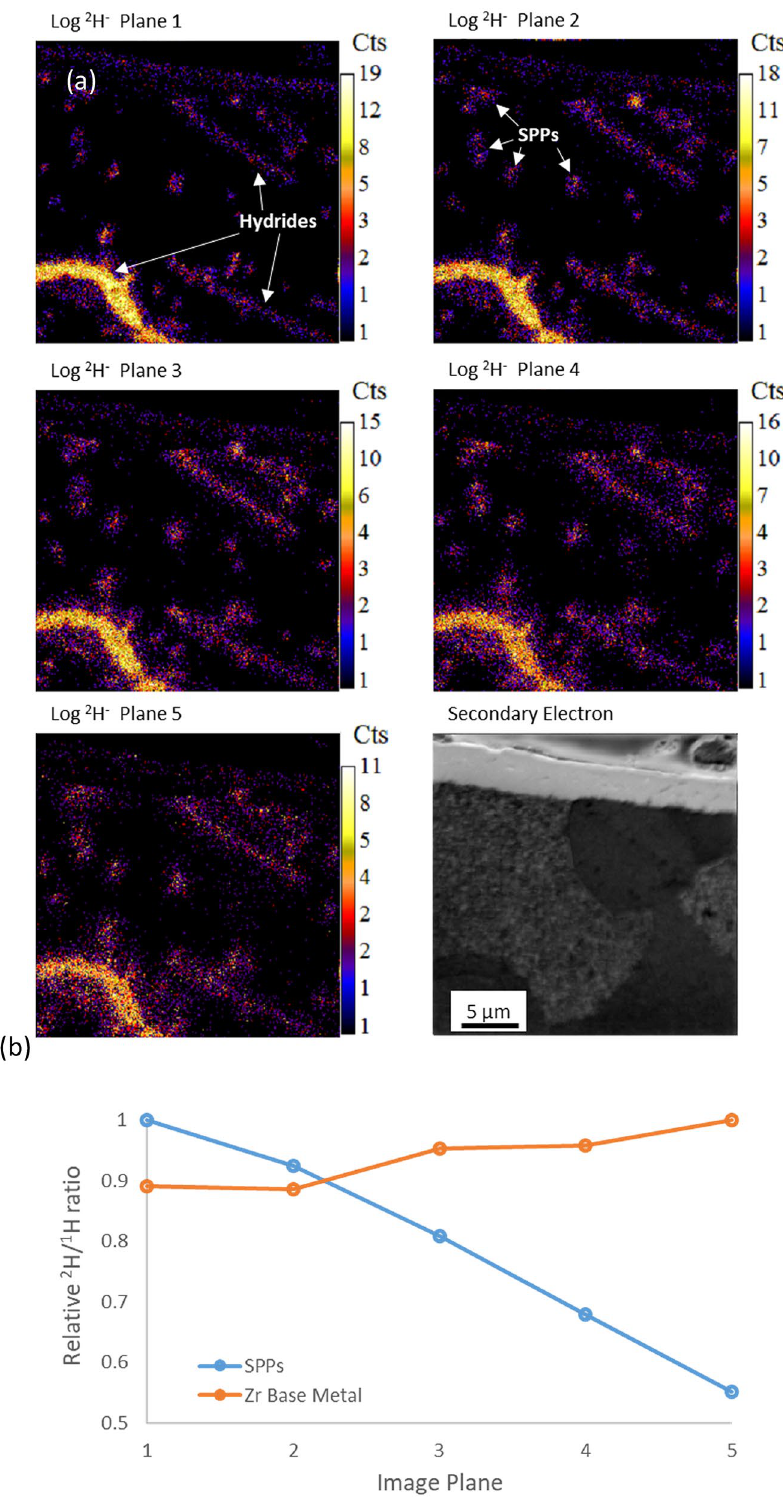
Figure 5. ( a ) NanoSIMS 2 H images from the cross section of a Zry-2 sample corroded for 283 days in autoclave, 5 consecutive image planes and the SE image. The hydride and the enrichments around the SPPs become diffuse and the signal strength decreases with increasing image depth. ( b ) Shows the relationship between image plane and 2 H/ 1 H ratio around the SPPs and in the α-Zr base